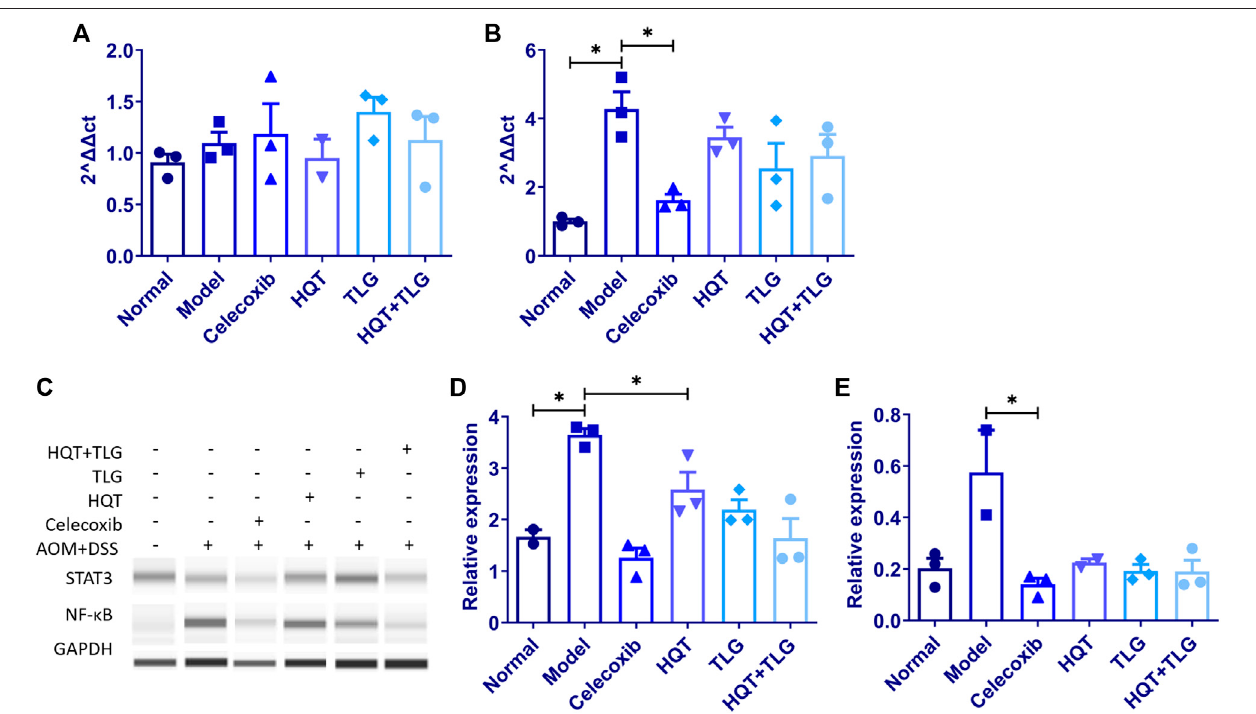
FIGURE5| ThemRNAexpressionofIL-6andIL-17,andtheproteinexpressionofSTAT3andNF- κ Bincolontissueofmiceineachgroup. (A,B) Expressionlevels of IL-6 and IL-17 mRNA. (C – E) Expression levels of STAT3 and NF- κ B protein. Compared with the model control group, * p < 0.05.